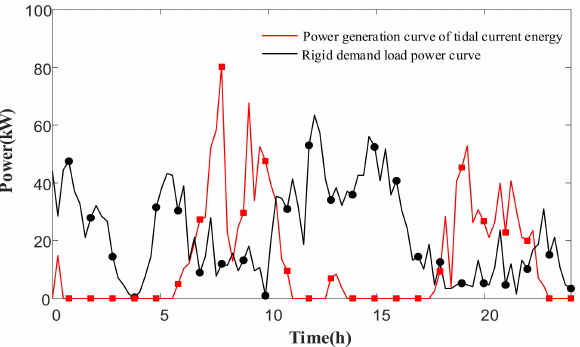
Figure 9. A 24-h curve of intraday tidal current energy generation output and island load.